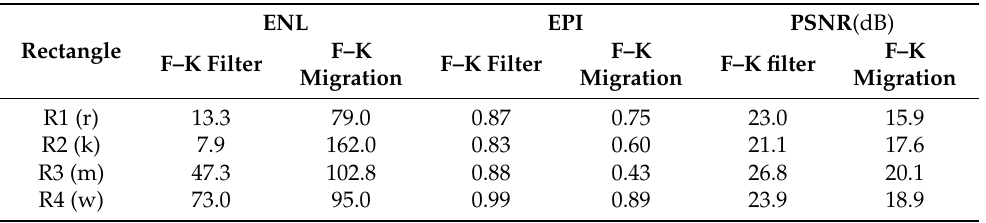
Table 2. Comparisons of quantitative indexes calculated after filtering in rectangular regions of Line 2 (AMY data; Figure